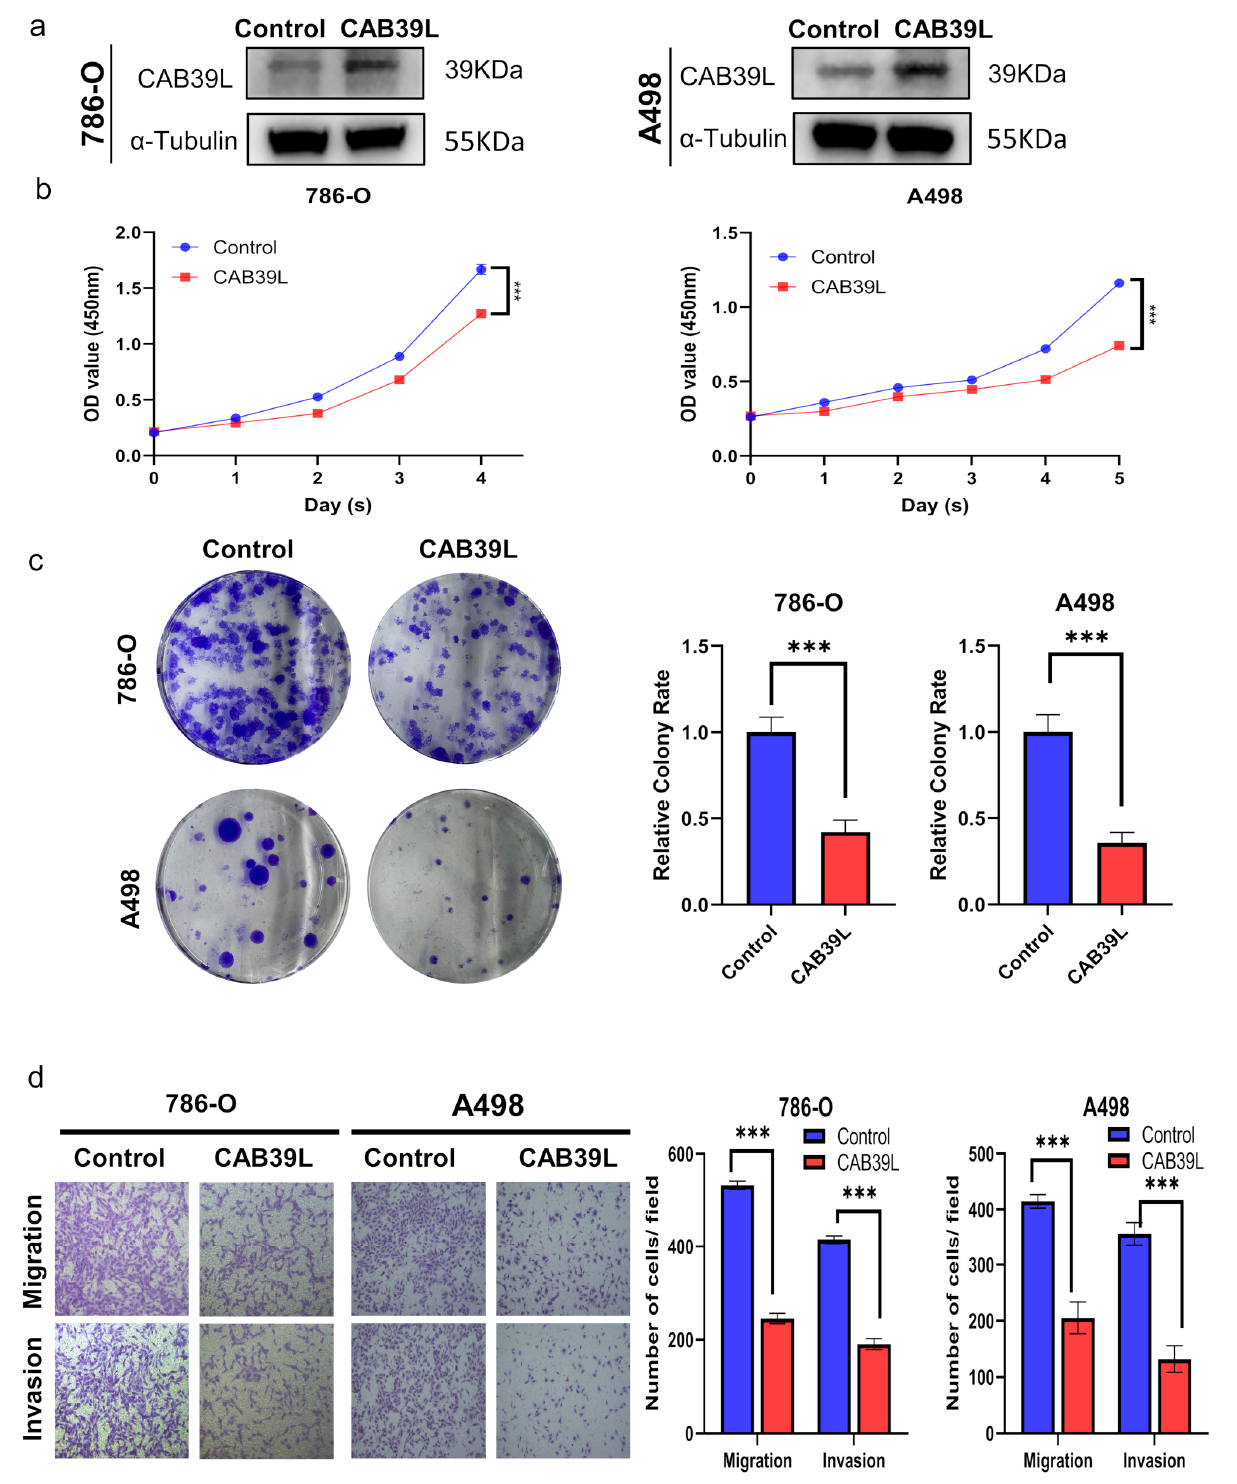
Figure 10. Overexpression of CAB39L inhibited the tumorigenicity and metastasis of KIRC cells in vitro. ( a ) Western blot detection of CAB39L expression after transfection of CAB39L overexpression plasmid in 786-O and A498 cells. ( b ) Impact of CAB39L overexpression on cell proliferation detected by CCK-8 assay. ( c ) Impact of CAB39L overexpression on cell proliferation detected by colony formation assay. ( d ) Impact of CAB39L overexpression on migration and invasion capacity of 786-O and A498 cells detected by transwell assays. *** p < 0.001.